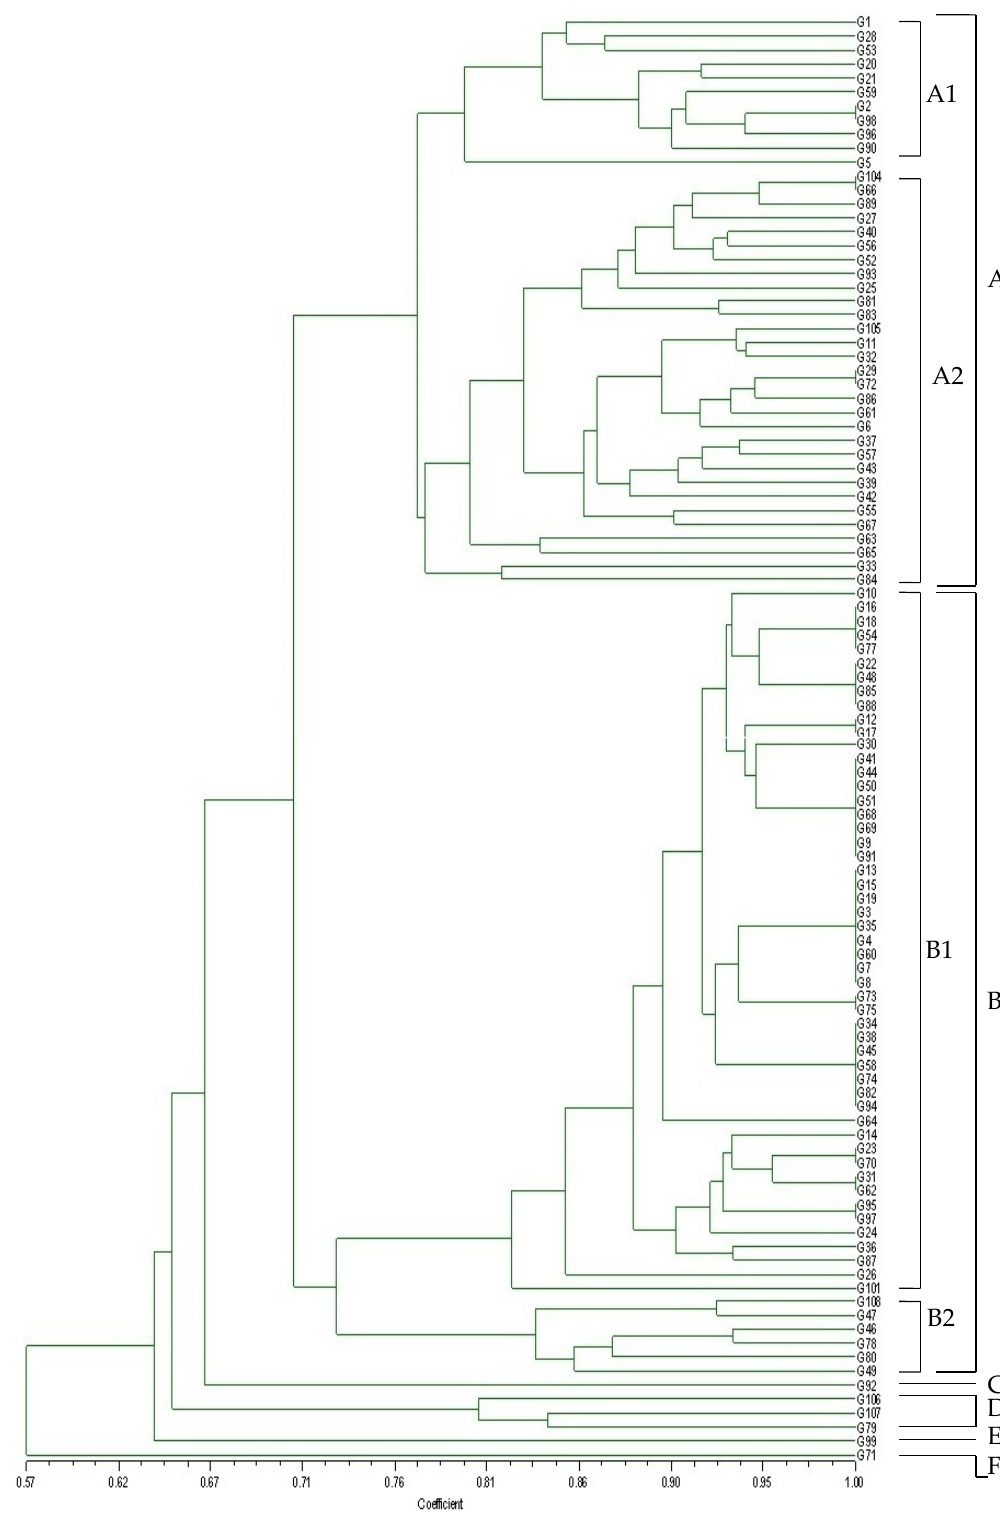
Figure 1. UPGMA dendrogram derived from the combined AFLP patterns using two different primer combinations of 104 O. oeni strains isolated from Australian Grenache wines. (six different principal clusters (A–F) were divided at the genetic similarity level of 71%).